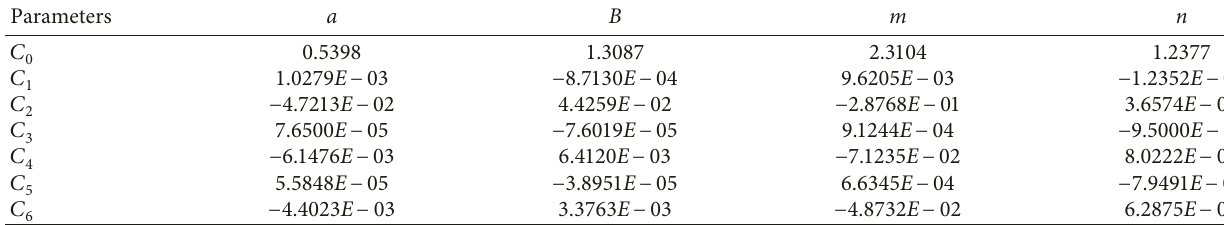
Table 2: Regression results for loading and unloading